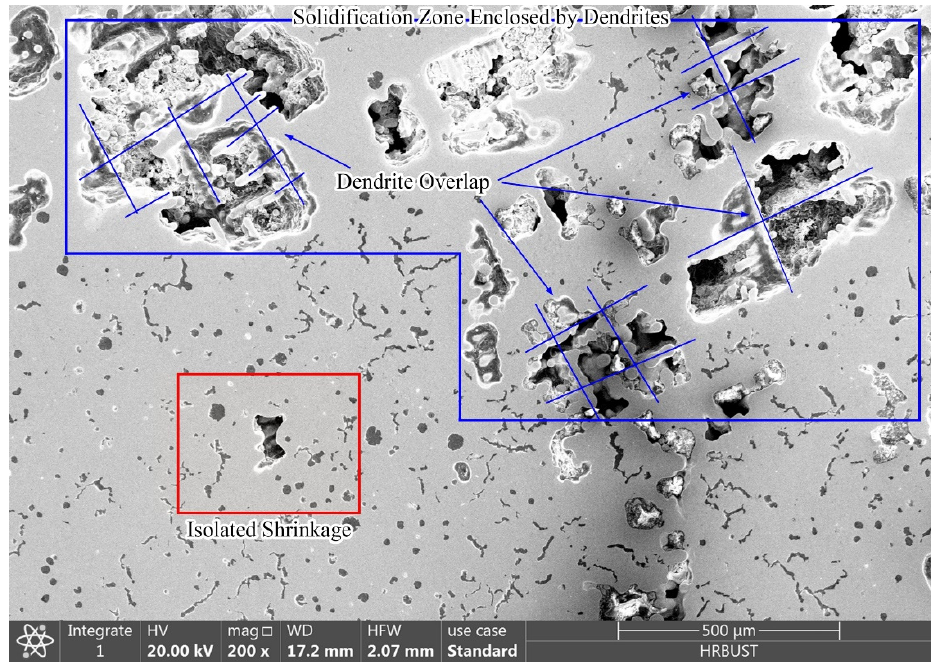
Figure 10. SEM of shrinkage defects in compacted graphite iron.